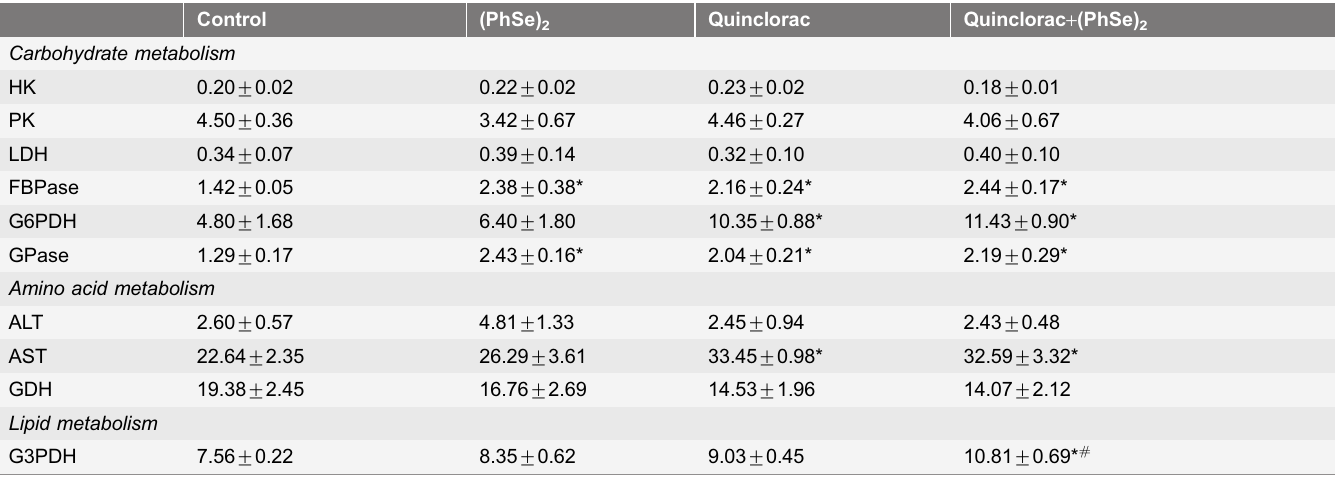
Table 3. Hepatic intermediary metabolism enzymes.